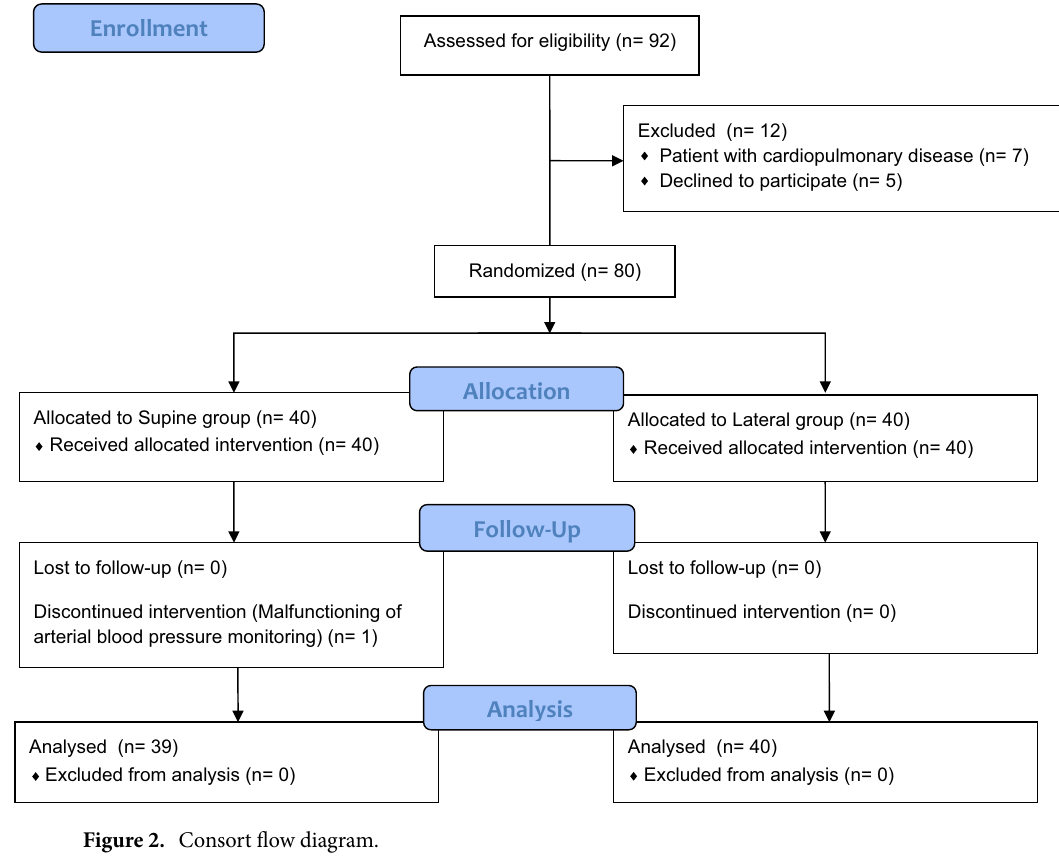
Figure 2. Consort flow